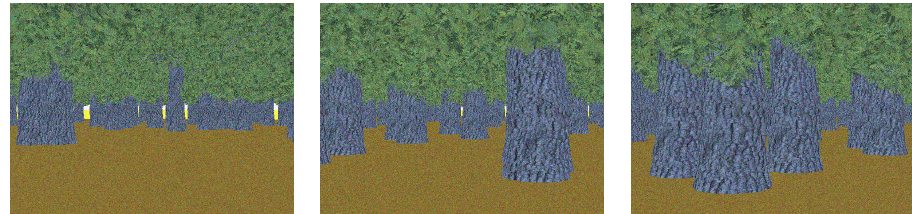
Figure 2. Sample images from two-class synthetic dataset. Best viewed in